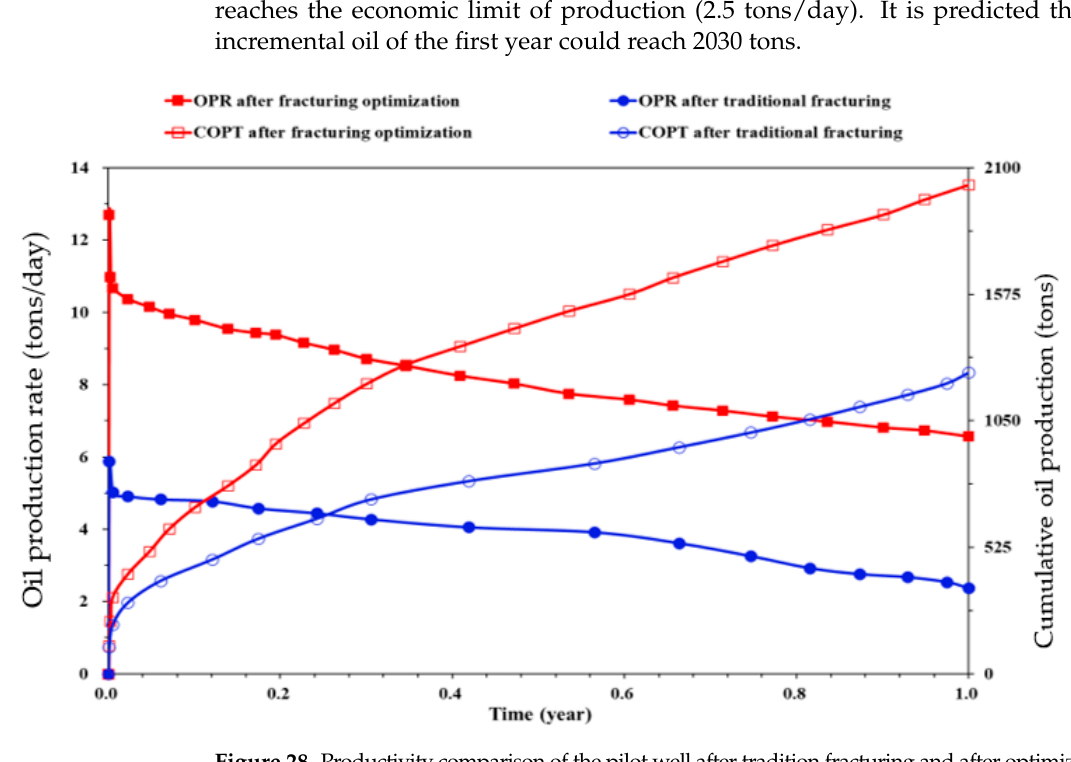
Figure 28. Productivity comparison of the pilot well after tradition fracturing and after optimized fracturing.